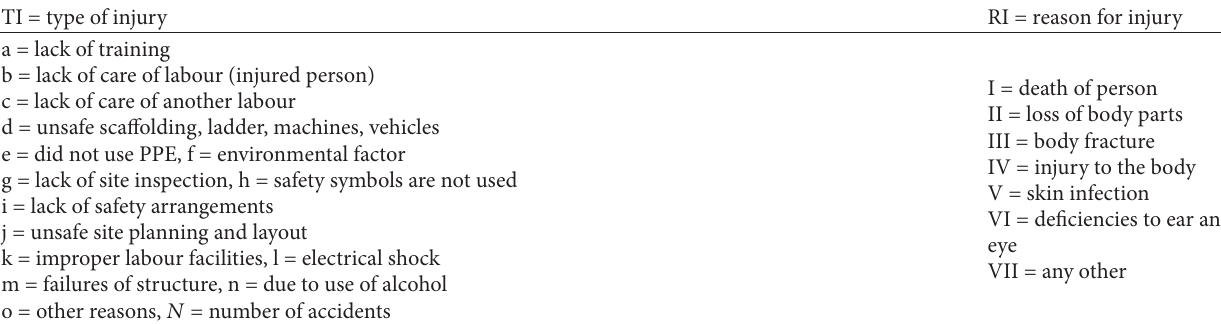
Table 3: Key words to represent accident.